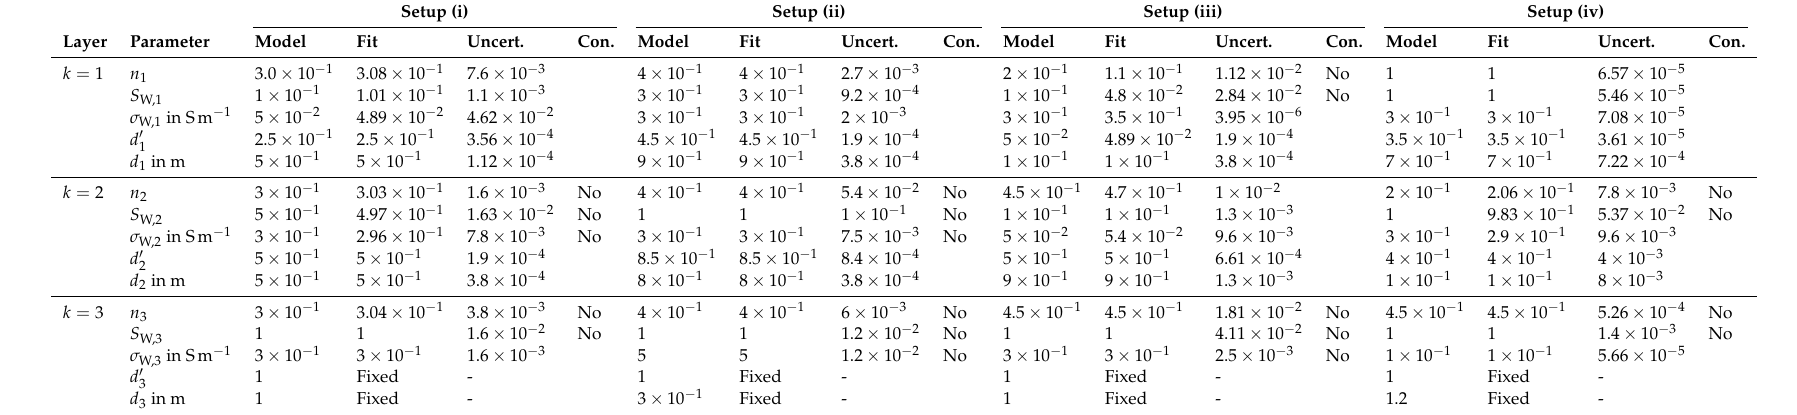
Table A1. Optimized parameters of synthetic data (Con. = Convergence, Uncert. = Uncertainty